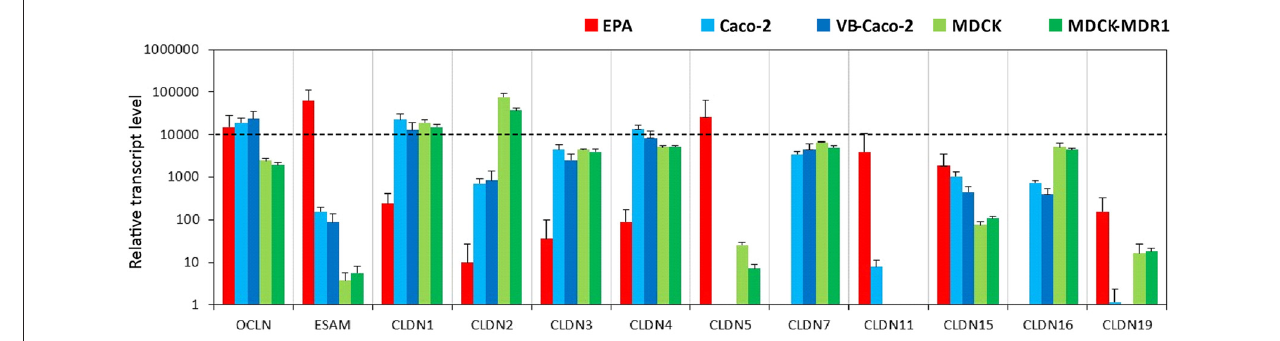
of the sodium-dependent vitamin transporter (SMVT, Slc5a6) and vitamin C transporters ASCT2 (Slc1a5) and ASCT1 (Slc1a4; Supplementary Table S2) genes were detected in rat brain endothelial cells ( Figure 2 ). Epithelial cells also expressed all these carriers. Except for the absence of dopamine transporter gene transcription (DAT, Slc6a3), low transcript levels of the noradrenalin (NET, Slc6a2), serotonin (SERT, Slc6a4), and GABA (GAT1, Slc6a1; GAT2, Slc6a13; GAT3, Slc6a11) genes were seen in the BBB model (Supplementary Table S2). Epithelial